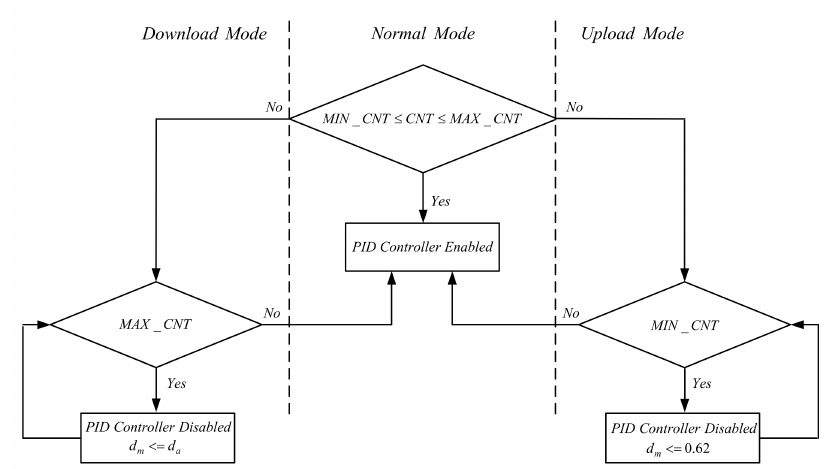
Figure 18. Block diagram for nonlinear